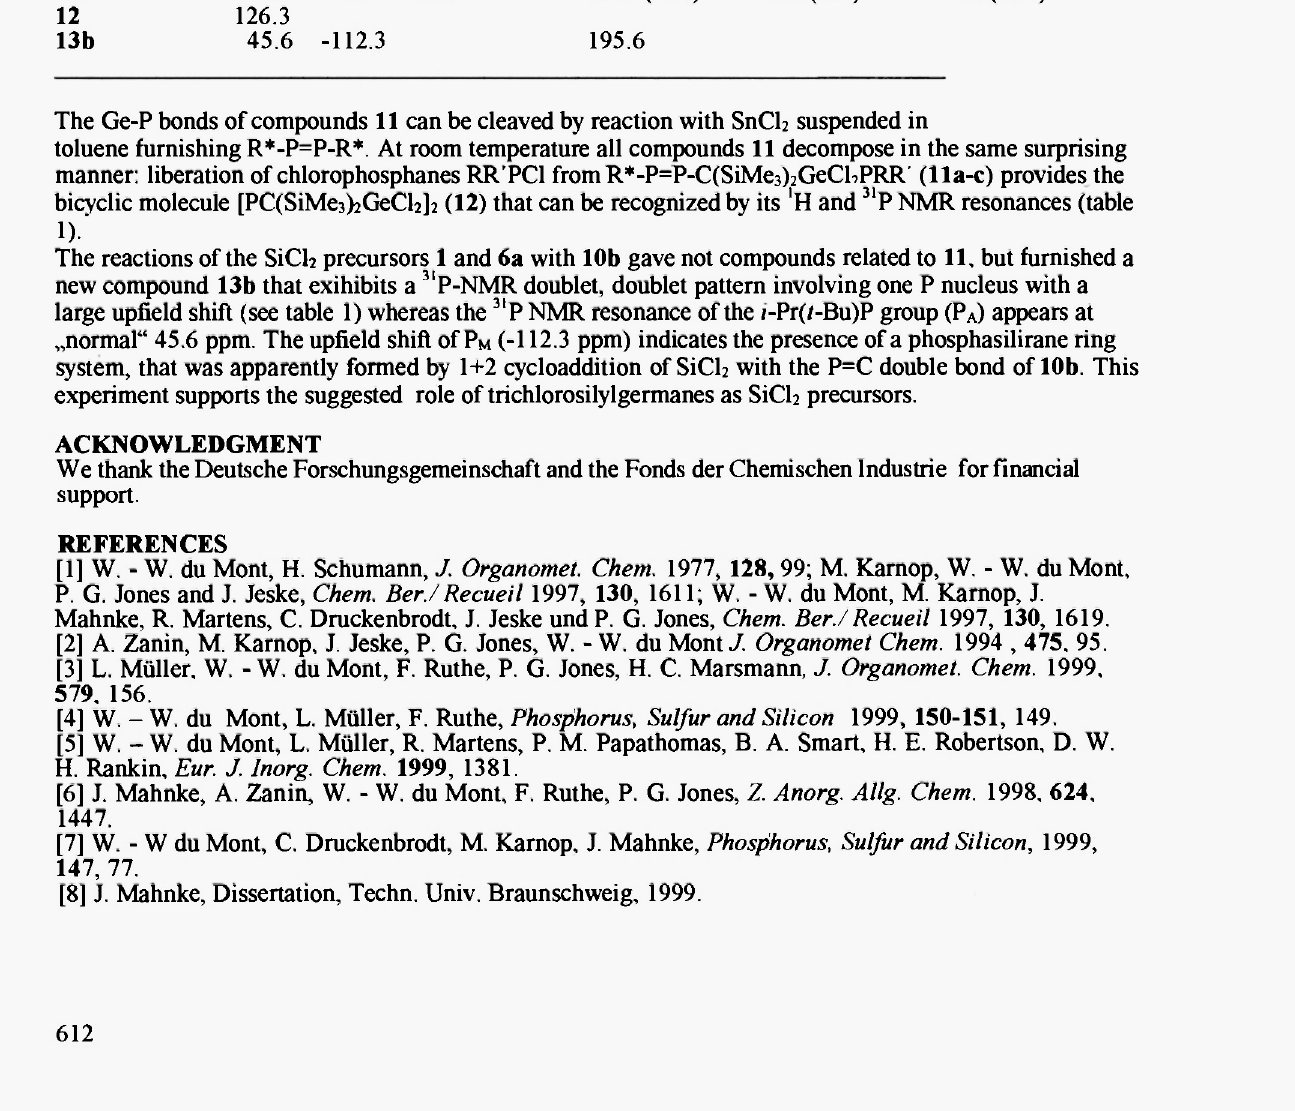
Table 1: 31 P-NMR data of compounds 10,11,12,13 δ Ρ |ppm| ± J( 3I P, 31 P) [Hz] Ρα PM Ρχ 10a [6] 453.7 1.6 220.8 10b [6] 452.1